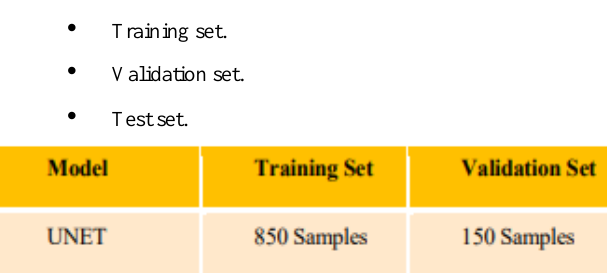
Fig. 8 : The high-level architecture for the proposed building detection methodology, which contains 4 main stages: preprocessing, image preparation, model training and building prediction